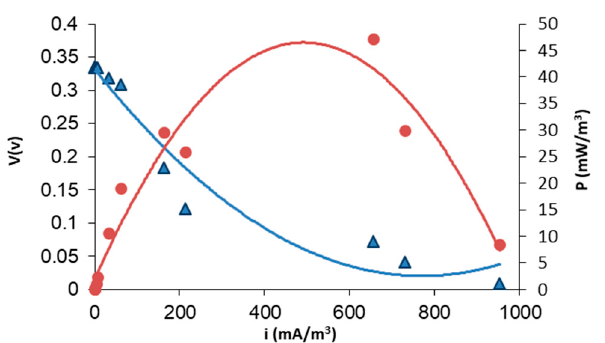
Figure 5. Polarization test of MFCs using white oil industry wastewater as feedstock and a polymer inclusion membrane based on [MTOA + ][Cl − ]. Polarization curve for MFCs (V vs. I). Power output curve (P vs. I). Calculations are based on anode liquid volume.